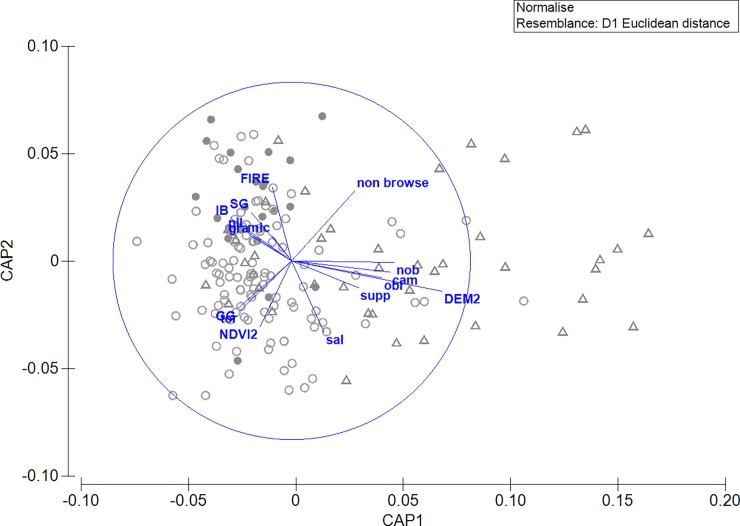
Canonical analysis of principal coordinates (CAP) illustrating site associations with environmental vectors (NDVI2, DEM2, common, ‘other’ important feed trees and non-browse species in study sites.Sites are grouped by conditional occupancy values (open circle = site occupied by koalas, closed circle = site with low likelihood (5–25%) of occurrence, and open triangle = site where koalas were likely absent (<5% probability of occurrence)). sal = Eucalyptus saligna, tor = Allocasuarina torulosa, gra = Eucalyptus grandis, mic = Eucalyptus microcorys, pil = Eucalyptus pilularis, GG = grey gum, IB = ironbark, SG = spotted gum, nob = Eucalyptus nobilis, obl = Eucalyptus obliqua, cam = Eucalyptus campanulata.